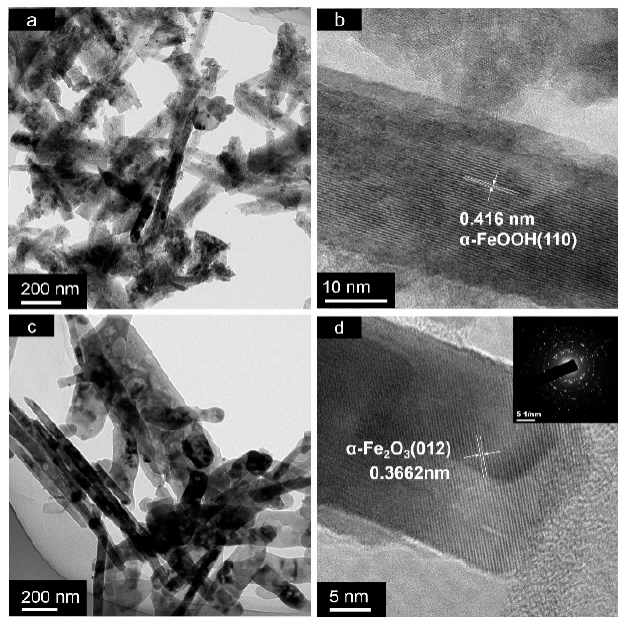
Figure 4. Transmission electron microscopy images of Au/FeOOH ( a , b ) and Au/Fe 2 O 3 ( c , d ).